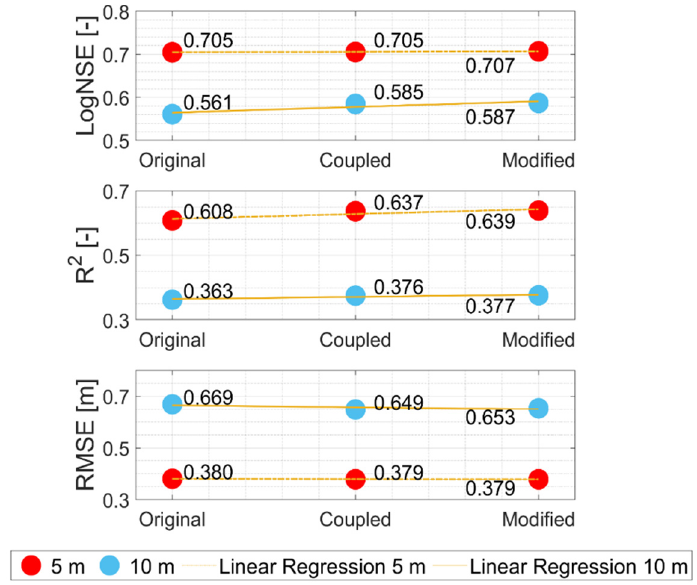
Figure 11. GOFs for the dense urban area.